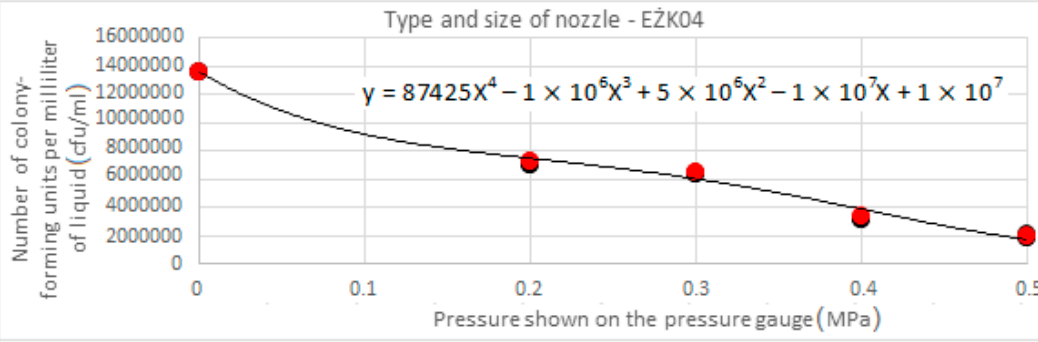
/ mL of liquid for E ˙ZK03.